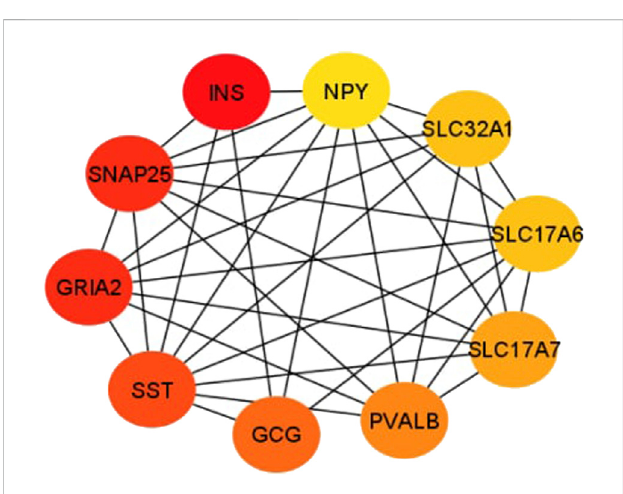
FIGURE 7 This sub-network shows the connection between hub genes. Red color denotes the degree of connectivity is highest and yellow color meansthelowestdegreeofconnectivityandthecolorchangesfromred to yellow means the degree of connectivity